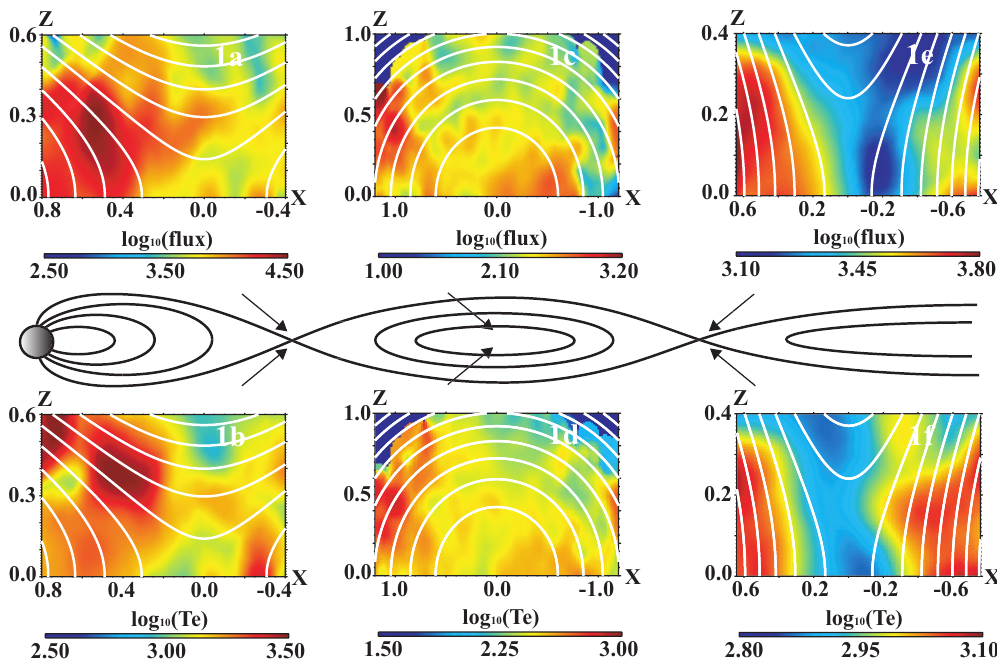
Fig. 27. Average profiles of the energetic electrons ( > 38keV) (top) and temperature of the thermal electrons (eV) (bottom) observed in the near-Earth, the middle tail, and the distant tail. The cartoon of the magnetotail is shown in the middle panel. (From Imada et al.,